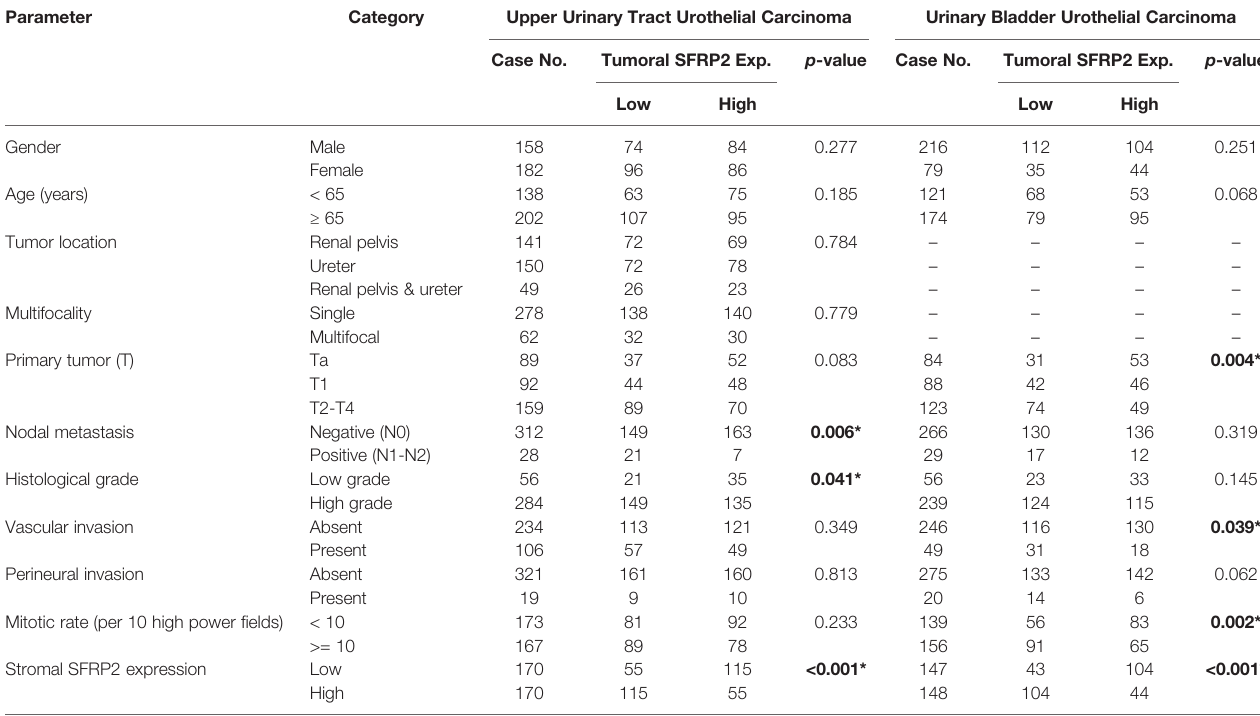
TABLE 3 | Correlations between tumoral SFRP2 expression and other important clinicopathological parameters in urothelial carcinomas.